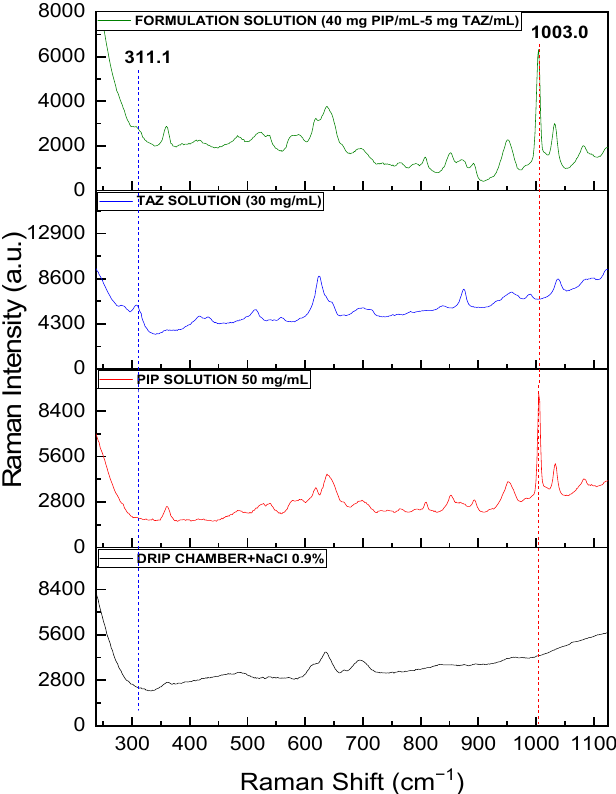
Figure 12. Raman spectra for solutions of pure PIP (50 mg/mL), pure TAZ (30 mg/mL), and the formulation (40.00 mg PIP/mL and 5.00 mg TAZ/mL), after the samples had been placed in the drip chamber, as well as the blank sample spectrum (drip chamber + NaCl 0.9%). PIP peak at 1003 cm − 1 is highlighted with the red dashed line, whereas TAZ peak at 311 cm − 1 with the blue one.